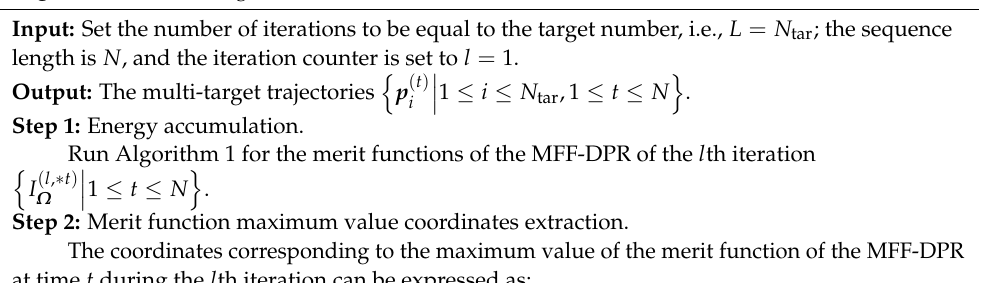
Algorithm 2 Multi-Target